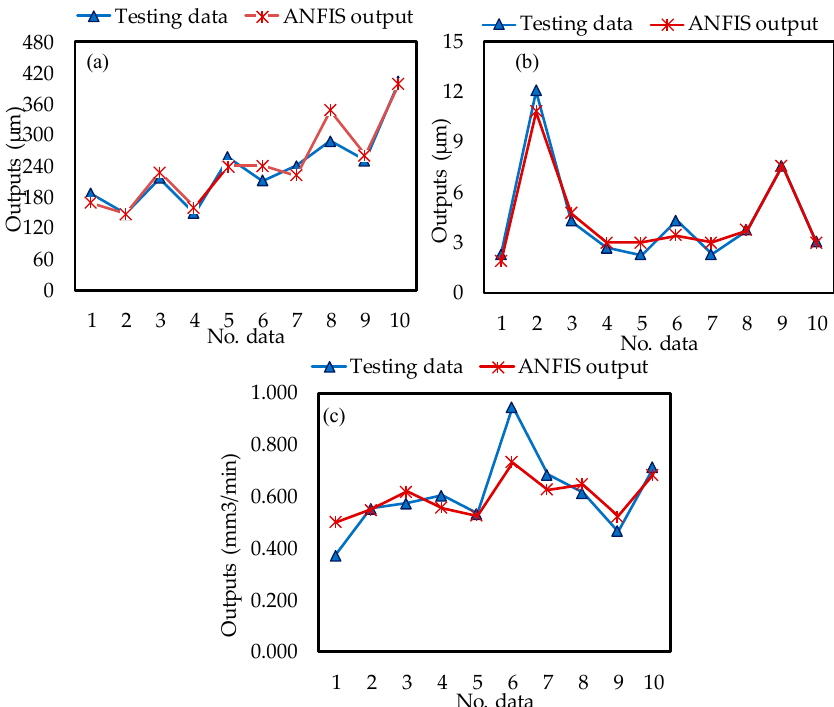
Figure 12. Comparison between the validating values and predicted ANFIS ( a ) D; ( b ) SR; ( c ) MRR.